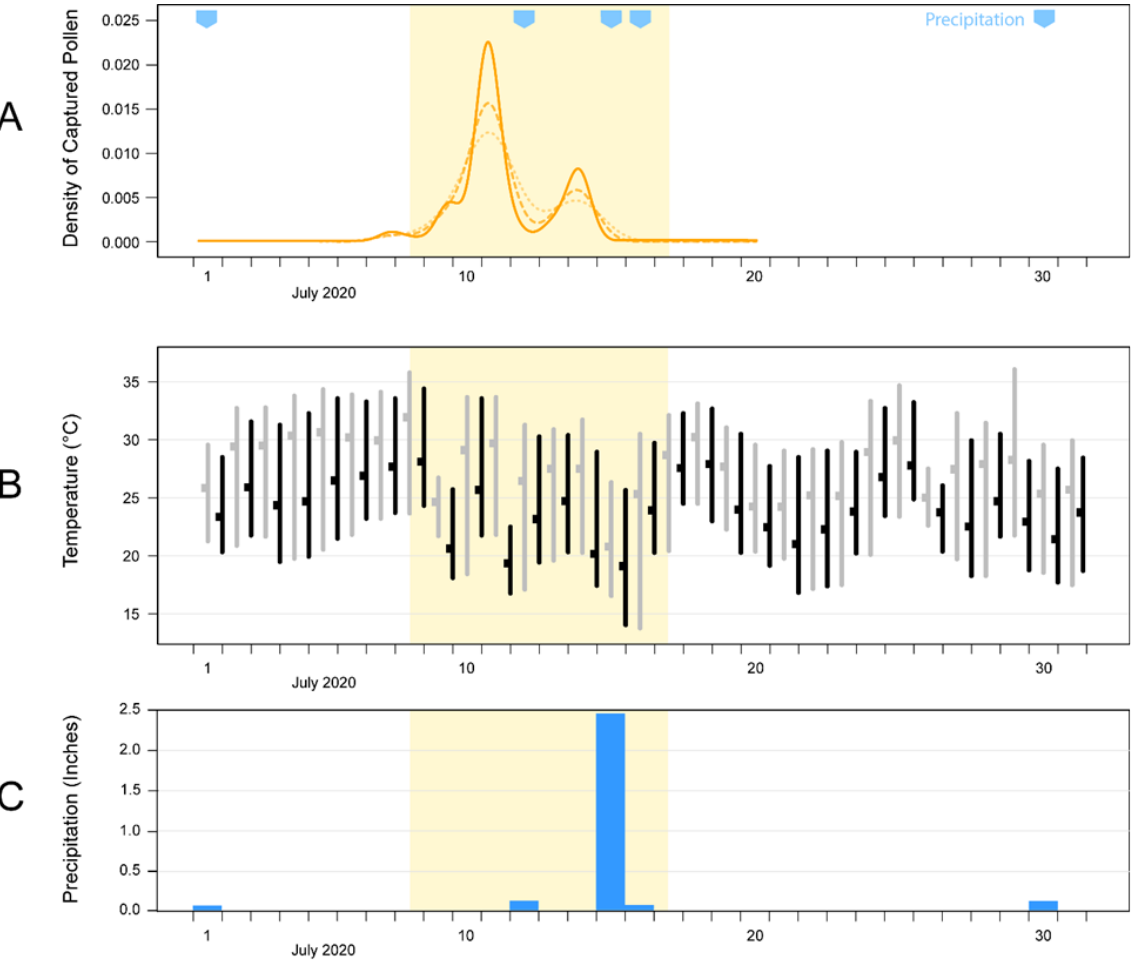
Figure 3. Timeline of July 2020 with A) kernel densities of captured pollen using three smoothing bandwidths of 10 (solid line), 15 (dashed line), and 20 (dotted line), B) temperature ranges in Celsius of diurnal (grey lines) and nocturnal (black lines) 12-hour periods with the mean indicated as an adjacent box, and C) precipitation in inches. The yellow band highlights the period of anthesis measured for D. obovata .